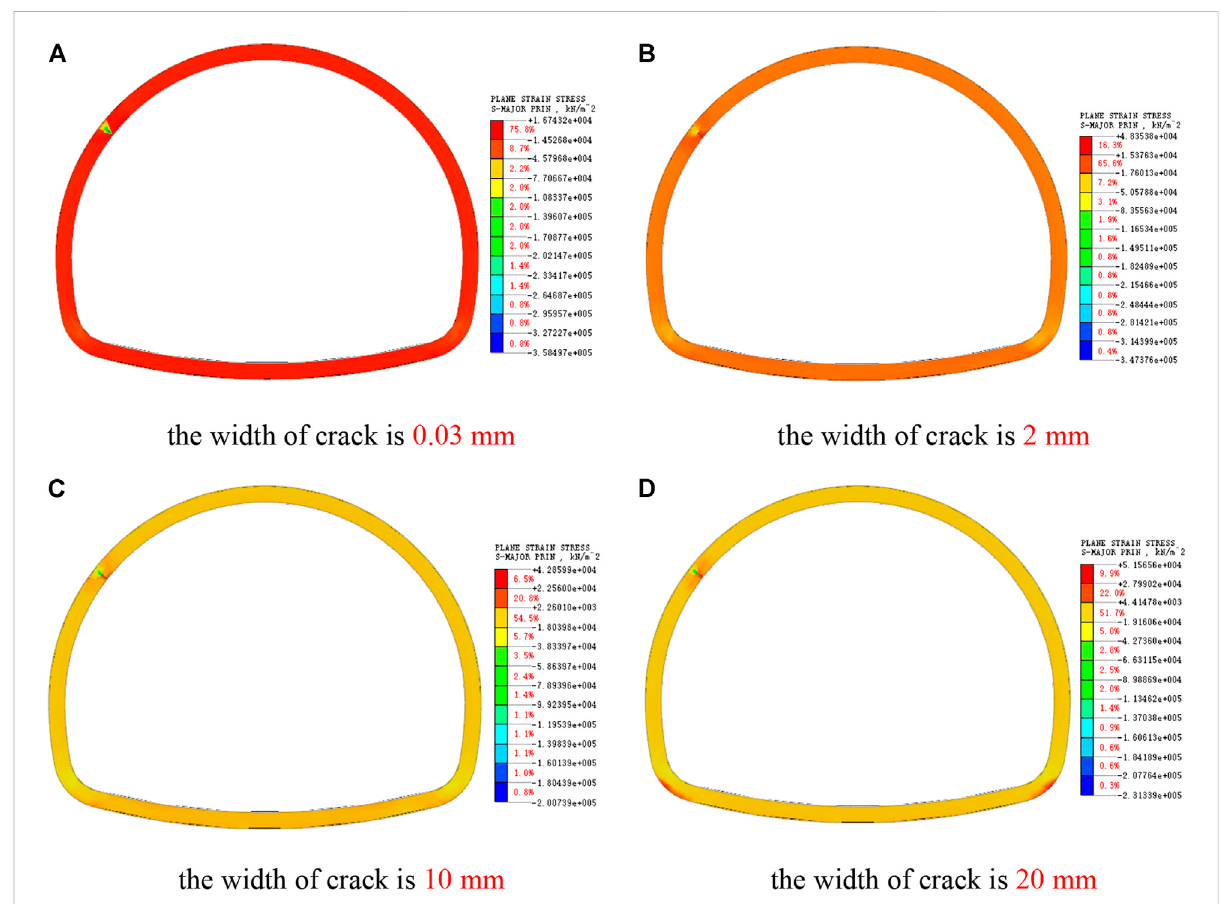
FIGURE 8 Cloudpictureoflarge principal stressofarchshoulder crack, (A) thewidth ofcrackis 0.03 mm. (B) The widthof crackis2 mm. (C) The width of crack is 10 mm. (D) The width of crack is 20 mm.